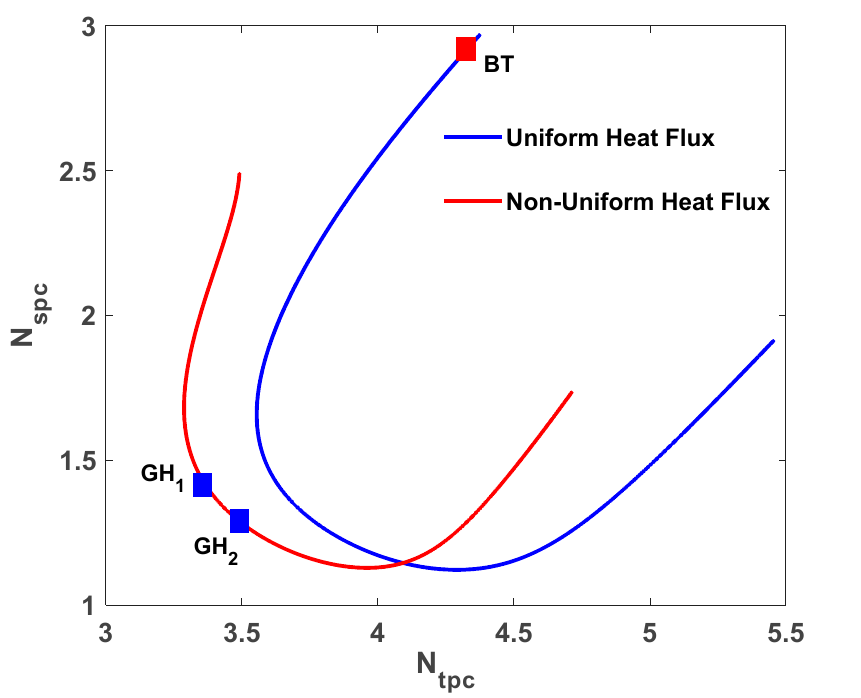
Figure 6. Stability characteristics of three parallel channels using a three-node approach.